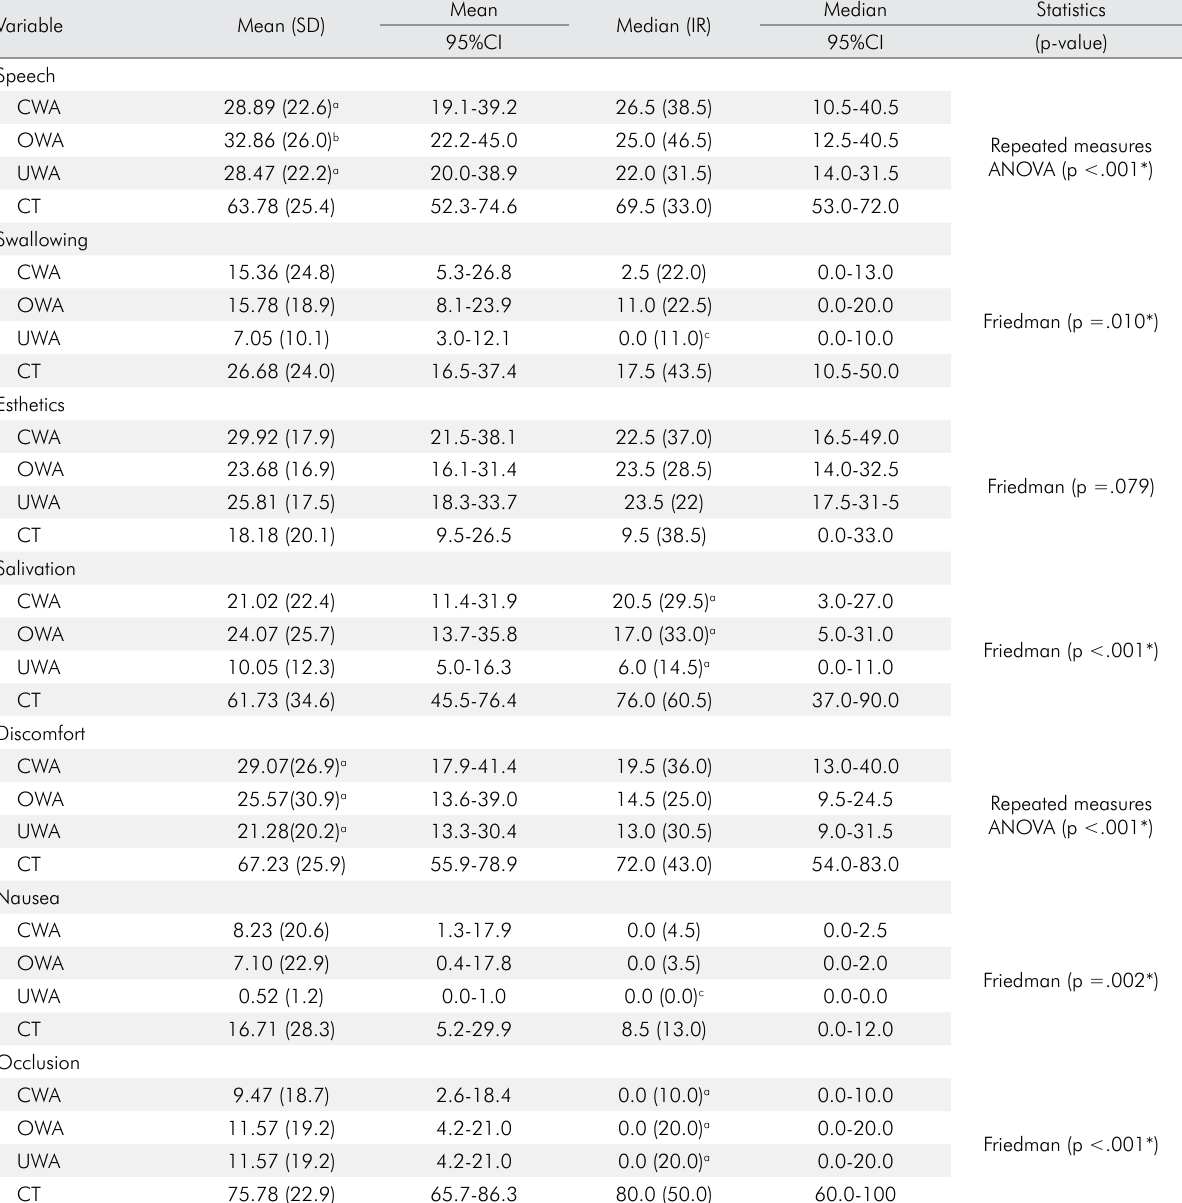
Table 1. Descriptive statistics of the perceptions of the four